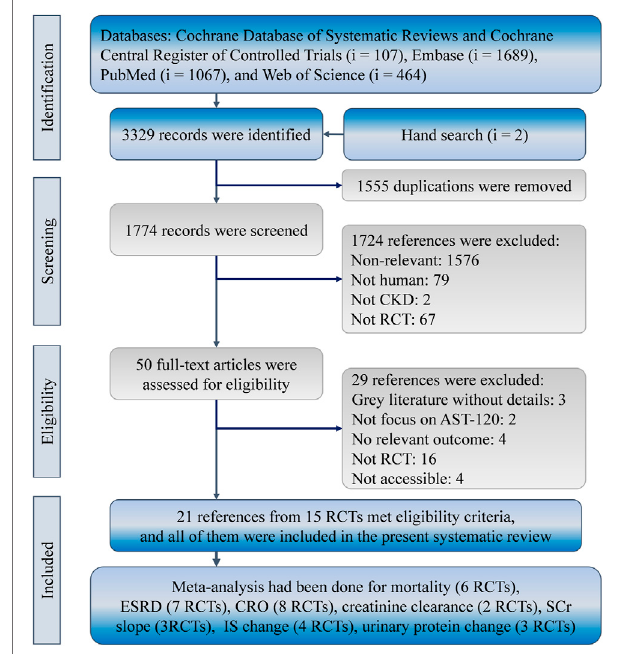
FIGURE 1 | Flowchart of the systematic review and meta-analysis according to PRISMA guidelines. CKD, chronic kidney disease; CRO, composite renal outcome; IS, indoxyl sulfate; RCT, randomized controlled trial; SCr, serum